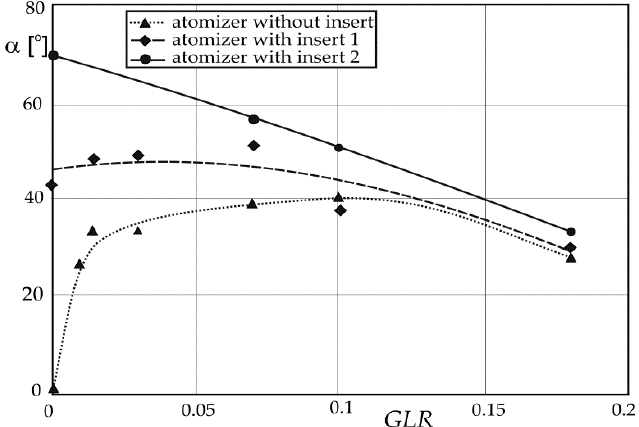
18 of 30 Figure 14. Diagram of the effervescent-swirl atomizer from the study [118,119]. Table 2. Summary of dimensions of individual components of atomizers [ 118 ]. ¦Ç c [Pa · s]